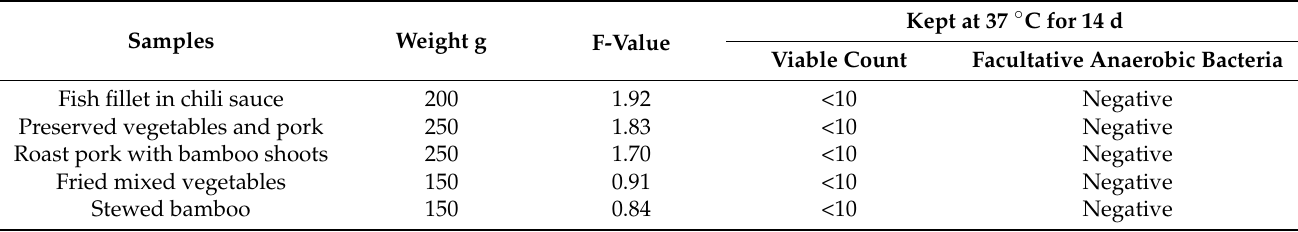
Table 2. F-values and amounts of bacteria amount in processed